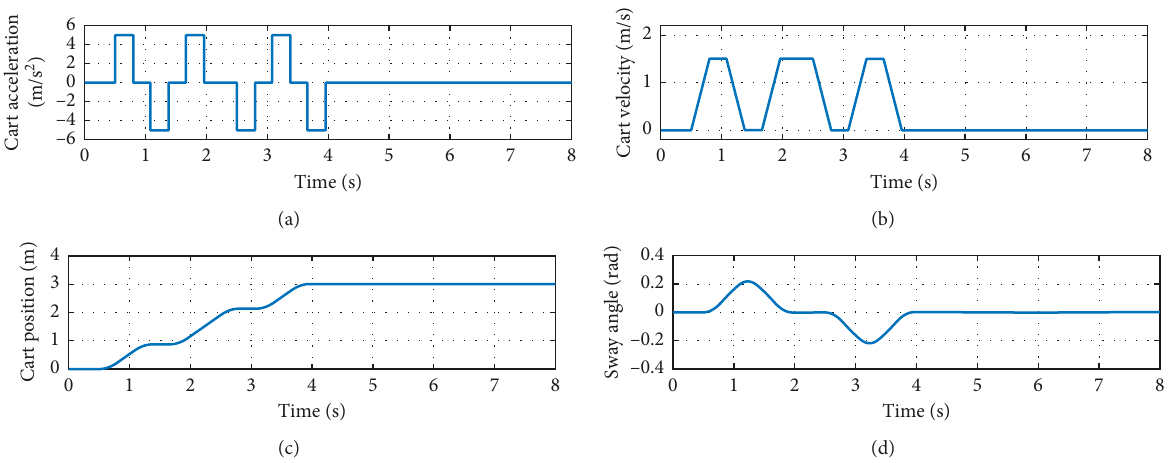
Figure 5: Simulationresults of cart motion andload sway inoverhead traveling crane withthe proposed operational method, which has no error l between standard and simulated rope lengths as l st sim (cid:31) 3m. (a) Cart acceleration. (b) Cart velocity. (c) Cart position. (d) Angle of load (cid:31)